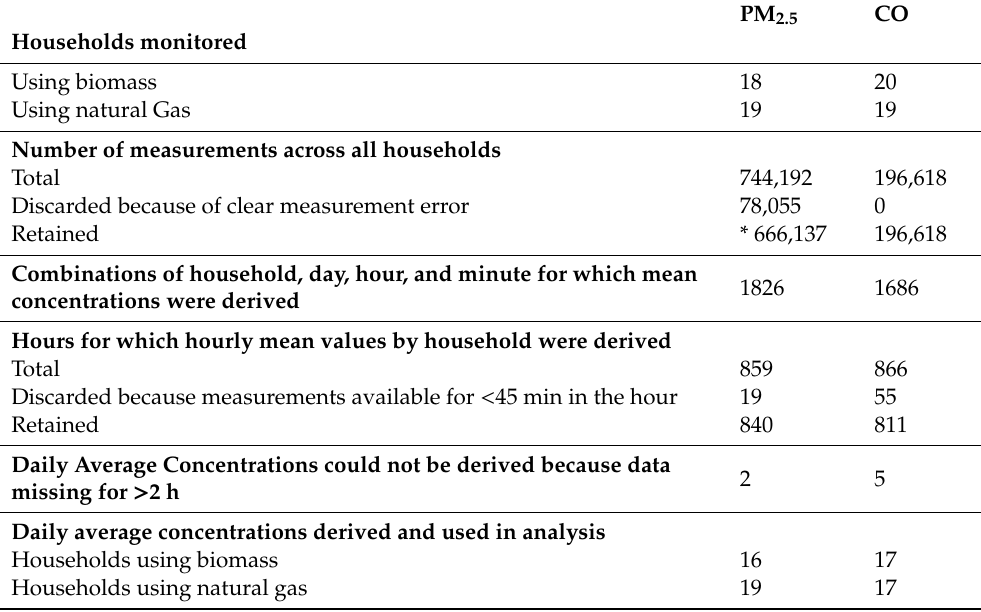
Table 1. Completeness of data.